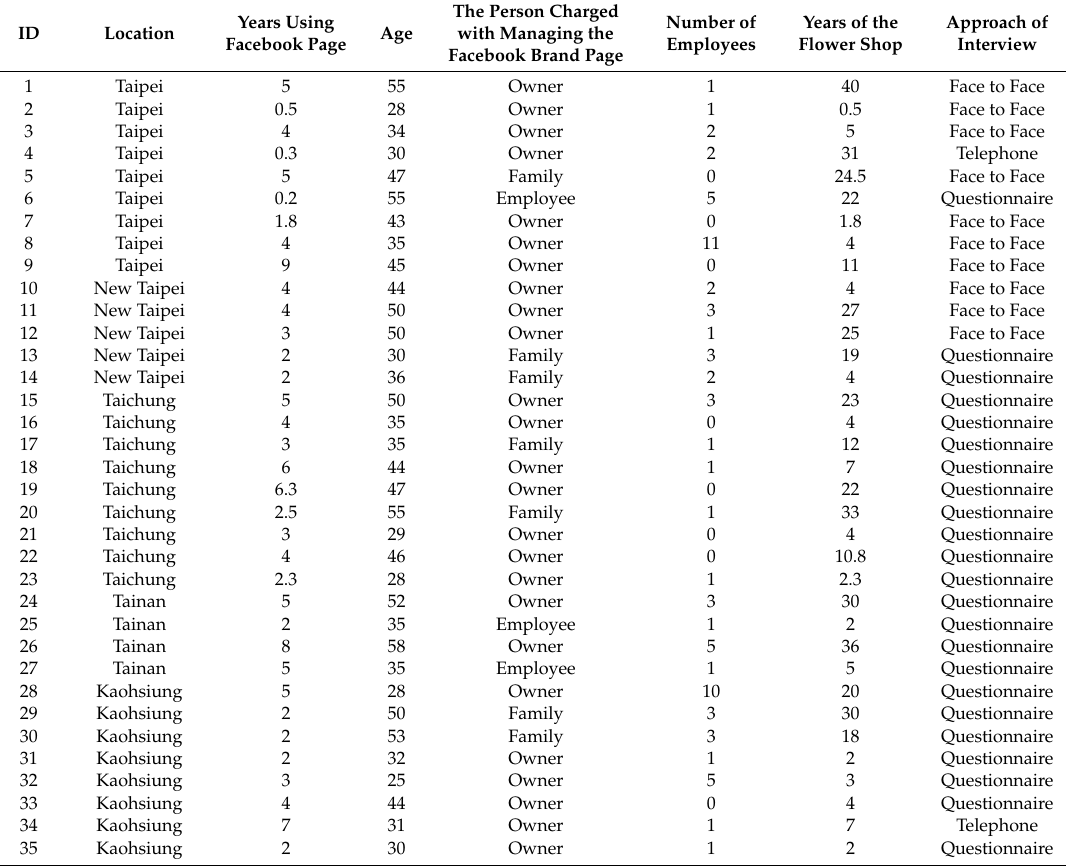
Table 2. Basic information of the flower shop owners, who were located in Taiwan and hosting a Facebook brand page, being interviewed for exploring the florists’ motivation, management strategy, barriers,